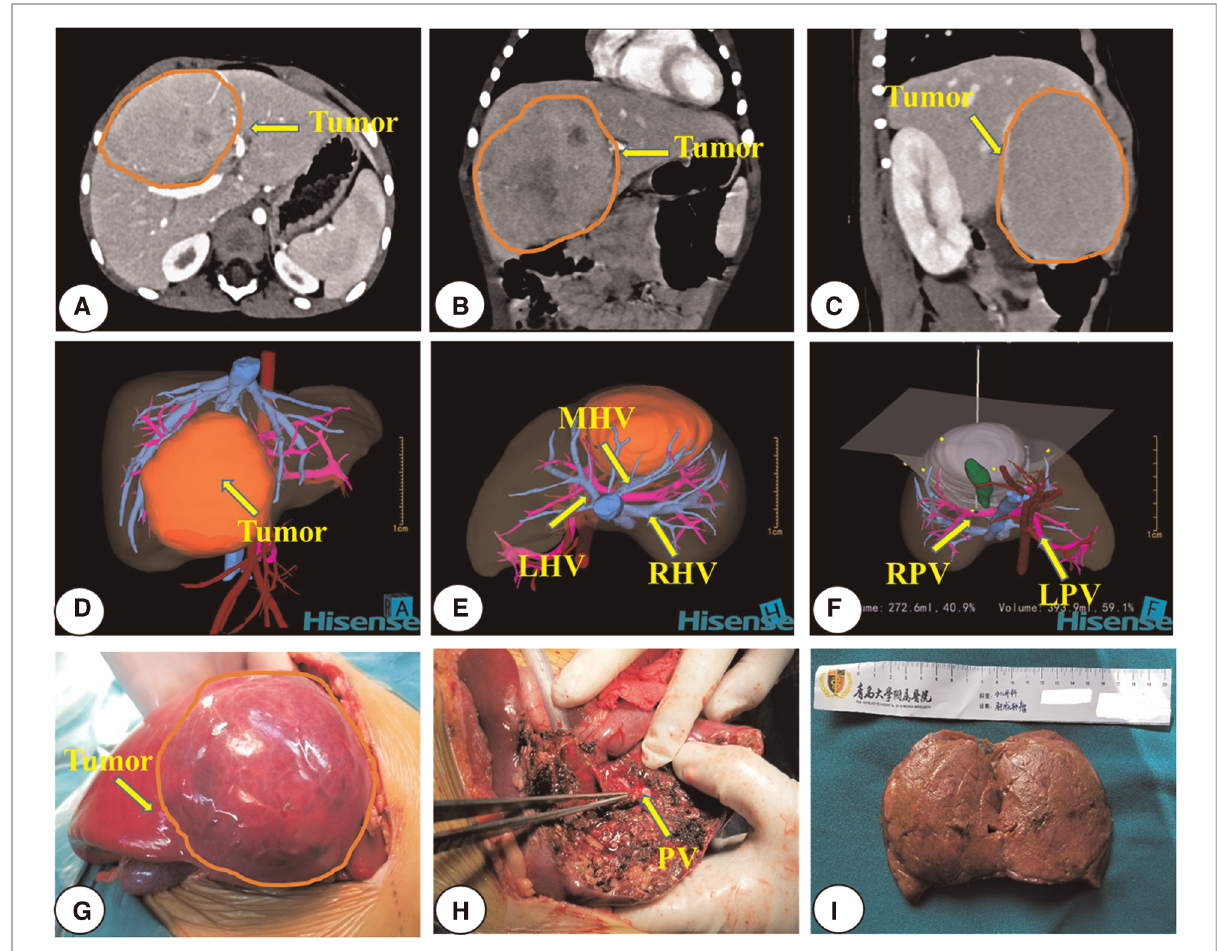
FIGURE 1 Representative preoperative assessment and surgical status of a patient with hepatoblastoma who underwent upfront surgery. ( A – C ) CT images; ( D – F ) 3D reconstruction images; ( G – I ) intraoperative observations. CT, computed tomography; 3D, three-dimensional; RPV, right portal vein; LPV, left portal vein; PV, portal vein; RHV, right hepatic vein; LHV, left hepatic vein; MHV, middle hepatic vein; AA, Abdominal